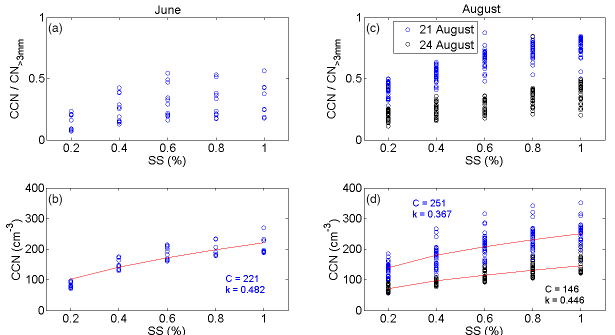
Figure 6. (a) Ratios of the medians for each SS scan between CCN and particles with diameters >3nm (CN > 3nm ) for June 2008 as a function of SS. (b) Medians for each SS scan of the total numbers of CCN as a function of SS for June 2008. (c) Ratios of the medians for each SS scan between CCN and particles with diameters >3nm (CN > 3nm ) for 21 and 24 August 2008 as a function of SS. (d) Me- dians for each SS scan of the total numbers of CCN as a function of SS for 21 and 24 August 2008. The red curves represent power-law function fits to the data with the coefficients C and k